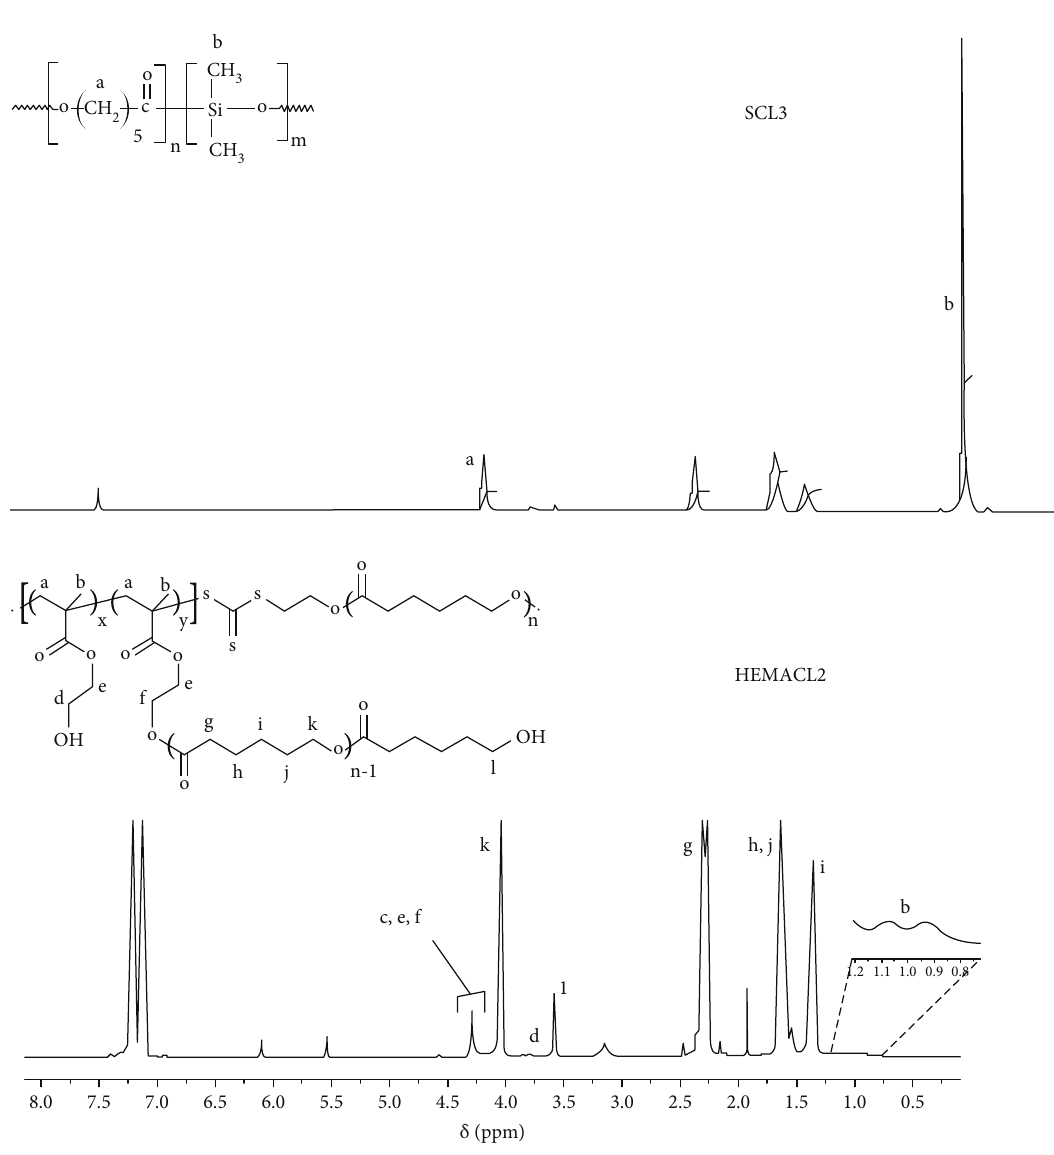
Figure 2: 1 H-NMR spectra of P (DMS- b - ε -CL) SCL3 and P (HEMA- co -(HEMA- g - ε -CL)- b - ε -CL) HEMACL2